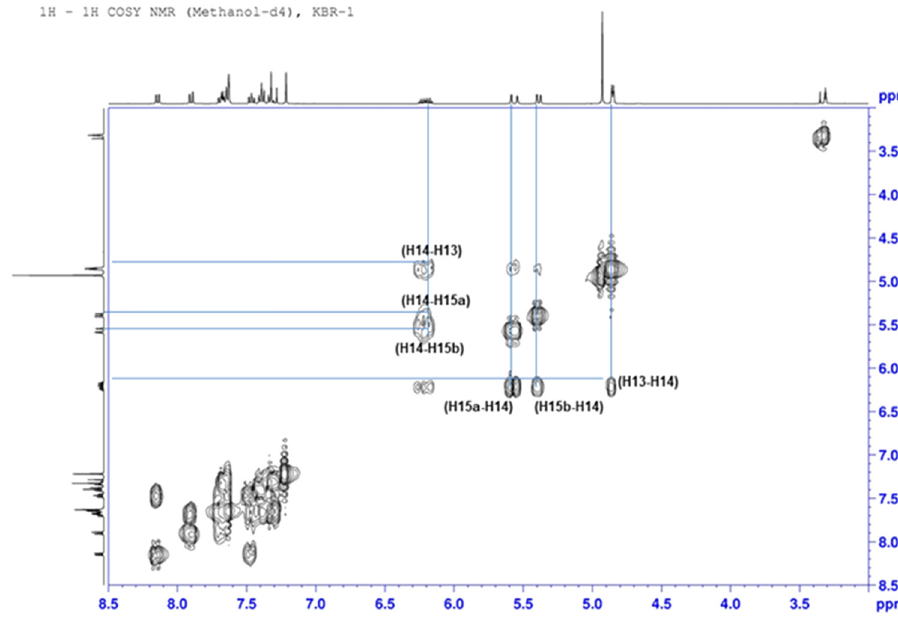
Figure 8: 1 H – 1 H COSY spectrum of compound 2h in methanol - d 4 .